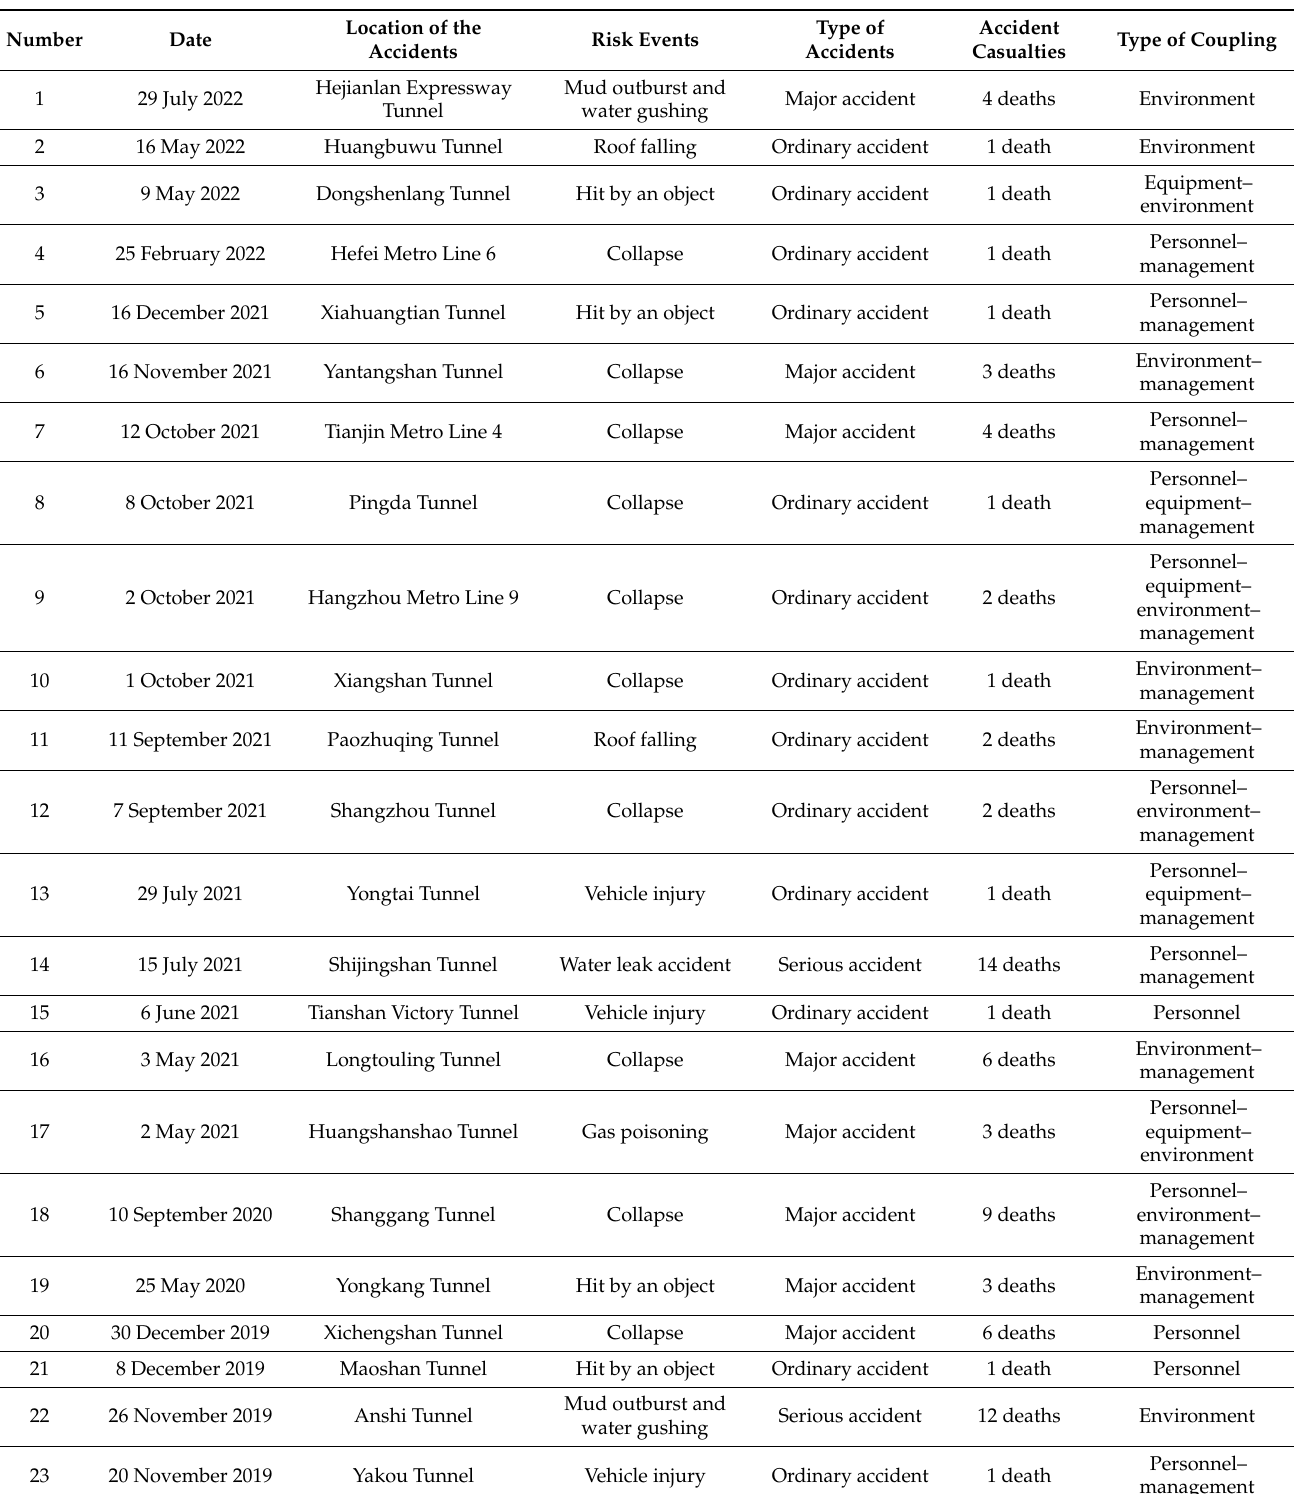
Table A1. Tunnel construction safety accident case